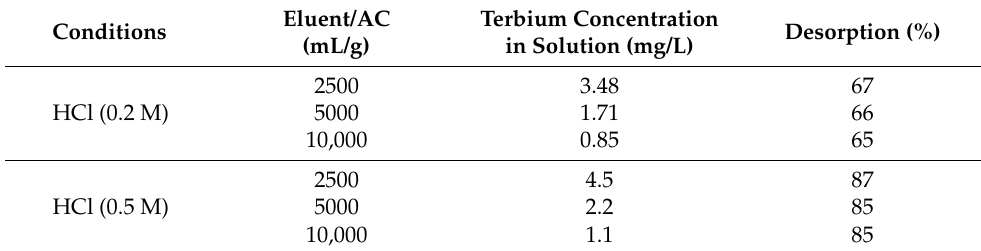
Table 5. Desorption results obtained from the different